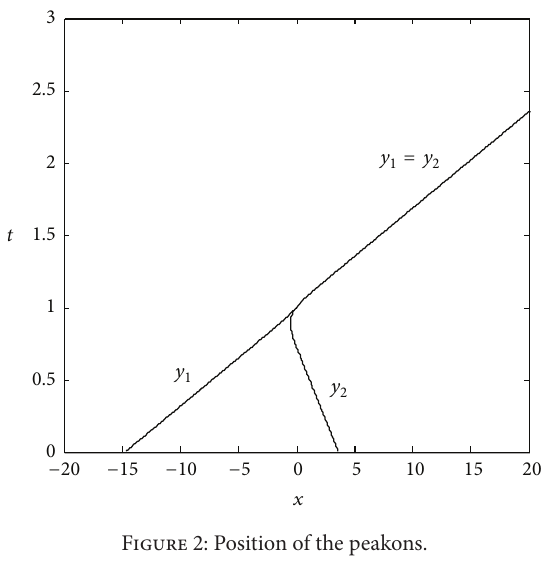
Figure 2: Position of the